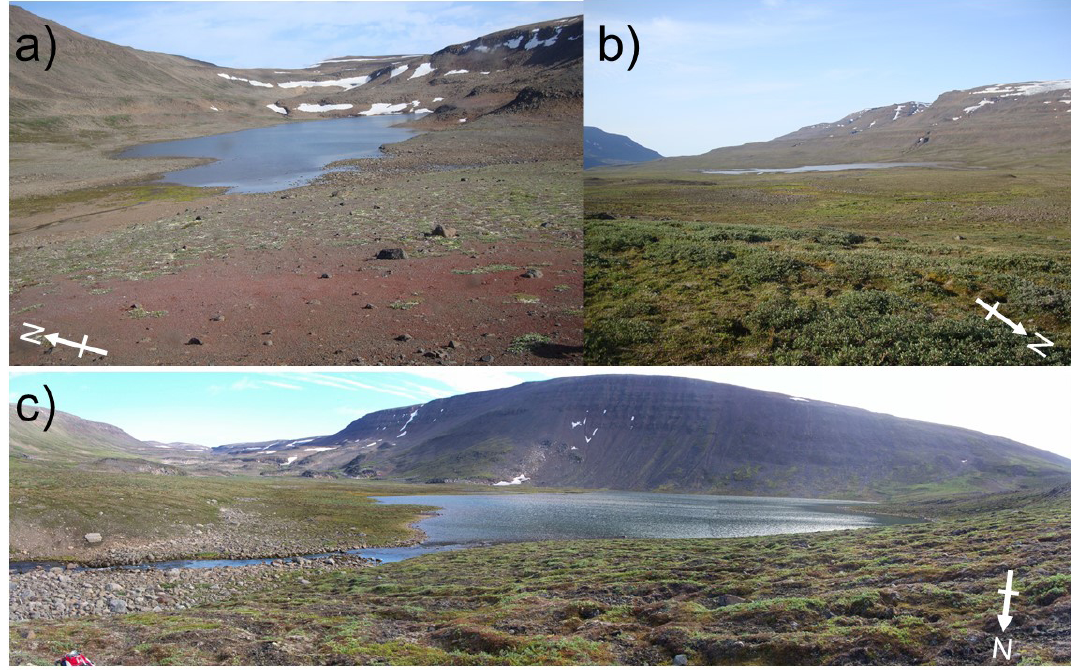
Figure 2. Images of study catchments and lakes on Disko Island in August 2013: (a) Lake Disko 2 (M. Stevenson); (b) Lake Disko 1 (M. Stevenson); (c) Lake Disko 4 (J. Bailey). Table 2. Selected water chemistry spot samples from Disko Island lakes in April and August 2013. Dashes denote missing values; BDL: below detection